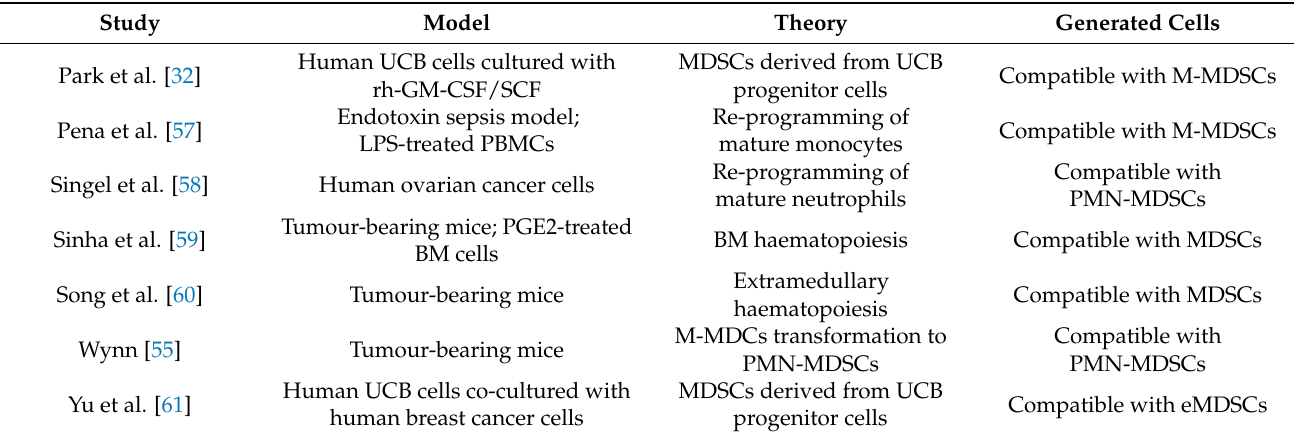
Table 1. Examples of studies investigating the origin of